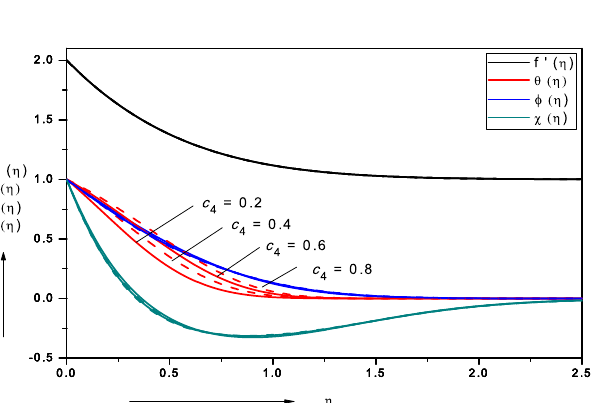
Figure 4. Effect of thermal conductivity parameter ( c 4 ) on nanofluid velocity, temperature, volume fraction and motile microorganism density